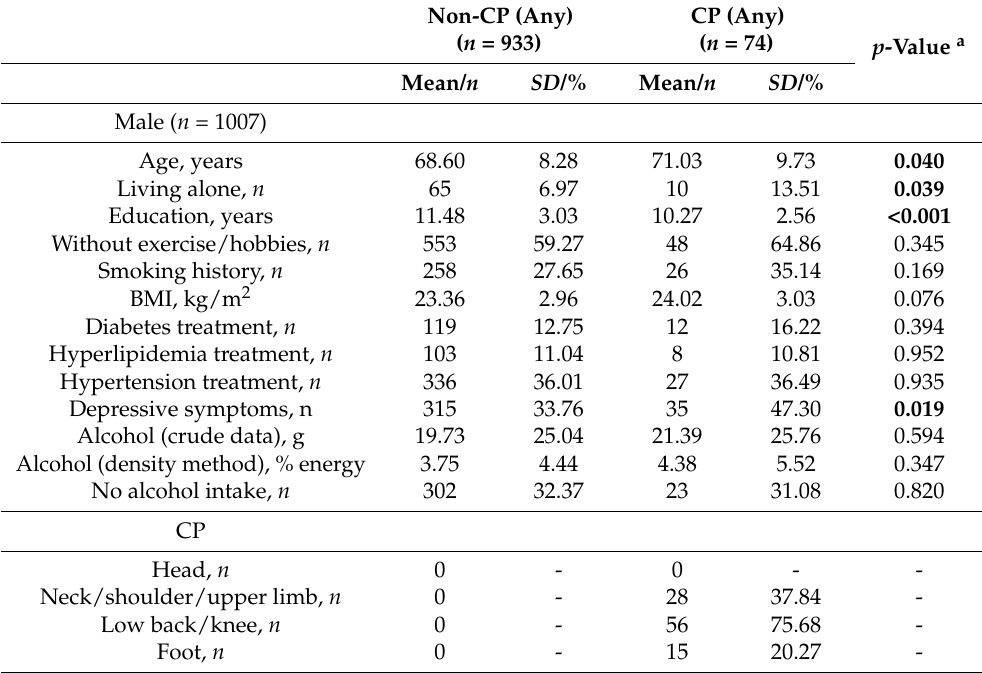
Table 3. Differences between the chronic pain groups in